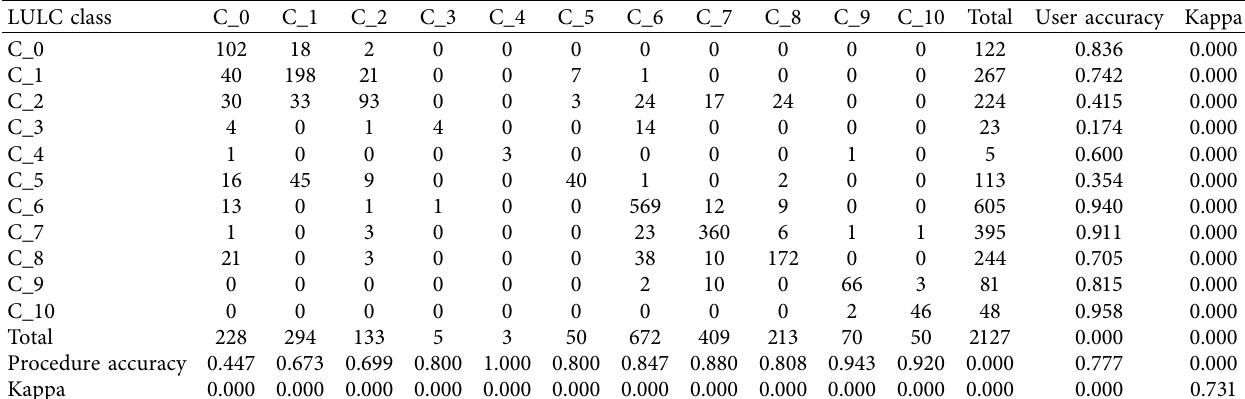
Table 4: Result of the accuracy assessment for the LULC classification based on the RF classifier without the MaSegFil approach. LULC